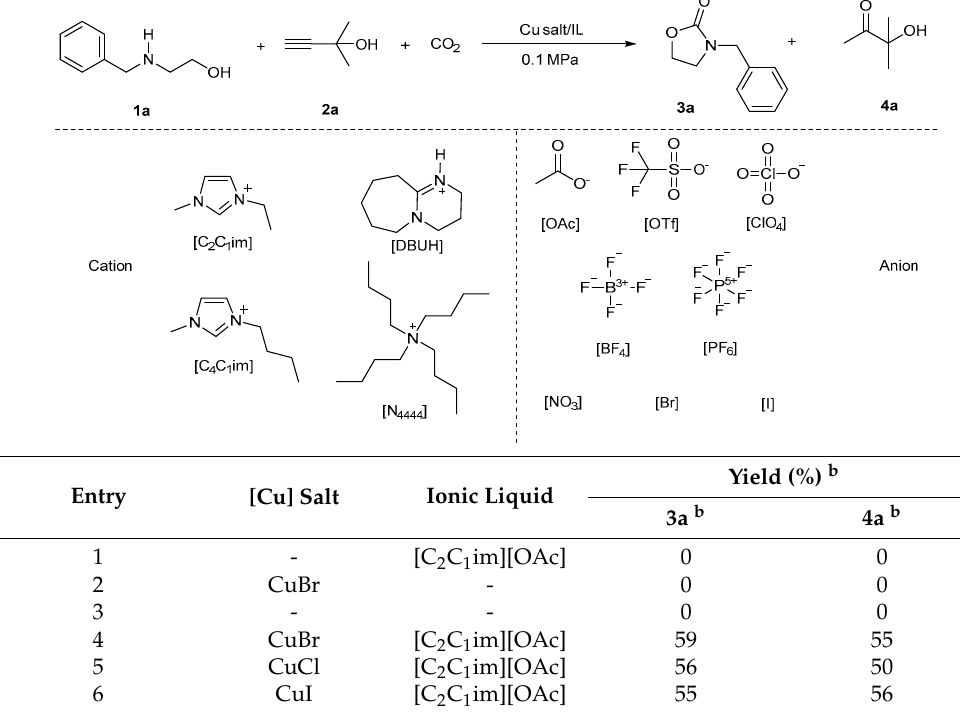
Table 1. Screen of the catalytic systems a .